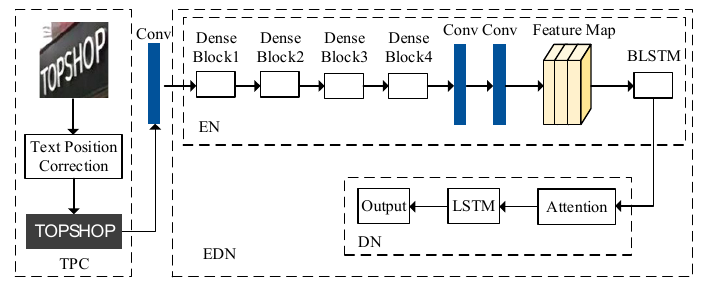
Figure 1. Overall structure of our text recognition algorithm.